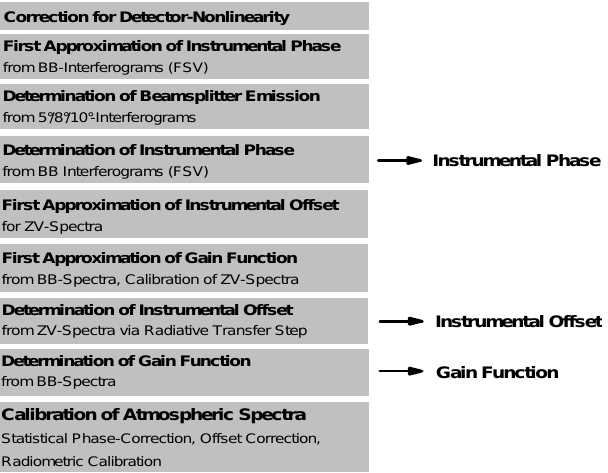
Fig. 4. Schematic representation of the full calibration cycle for MIPAS-STR measurements, including the determination of the detector non-linearity, instrumental phase, instrumental off- set and radiometric gain function (BB=blackbody measurements, ZV=zenith view measurements, FSV=phase correction according to Forman, Steel and Vanasse, for details see